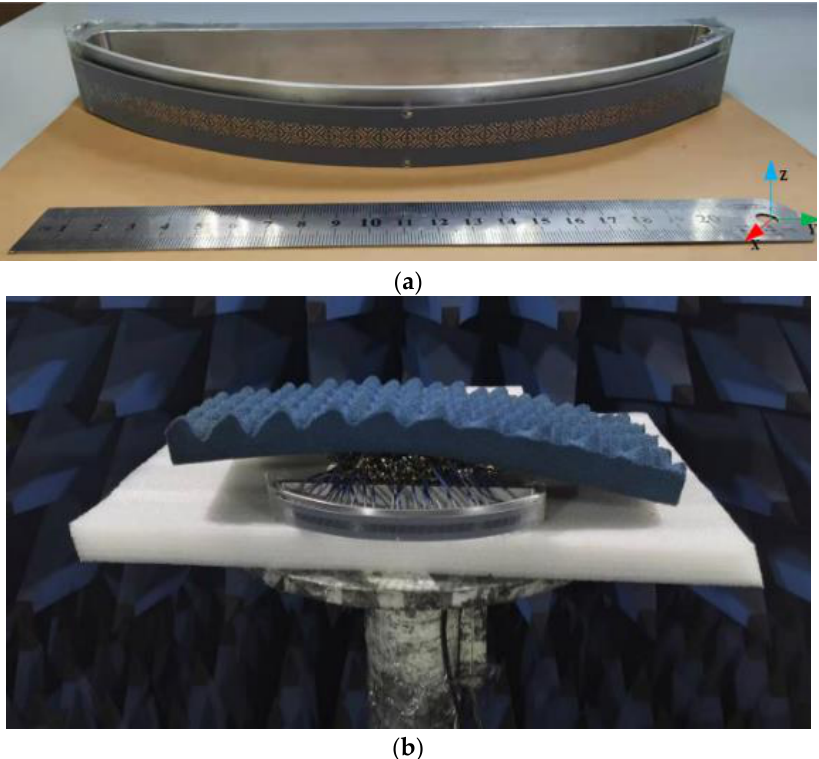
Figure 8. The prototype of the phased array. ( a ) Array photograph ( b ) the measurement scene.